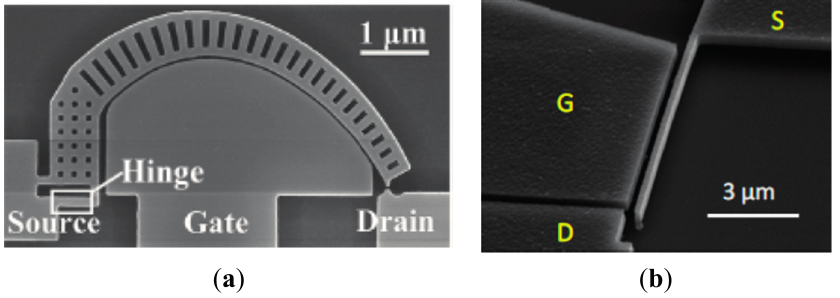
Figure 8. ( a ) NEM relay with a curved cantilever [57] (© 2014 IEEE, reprinted